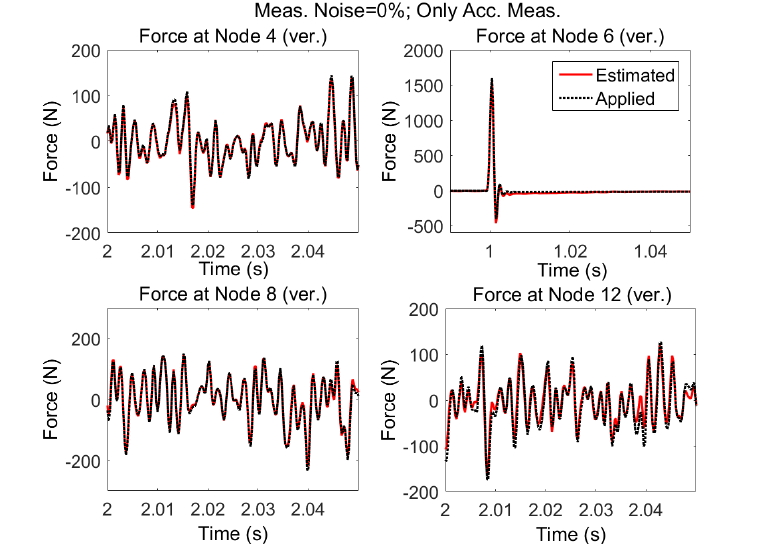
Figure 9. Estimated and applied forces shown for smaller time interval: detail of Figure